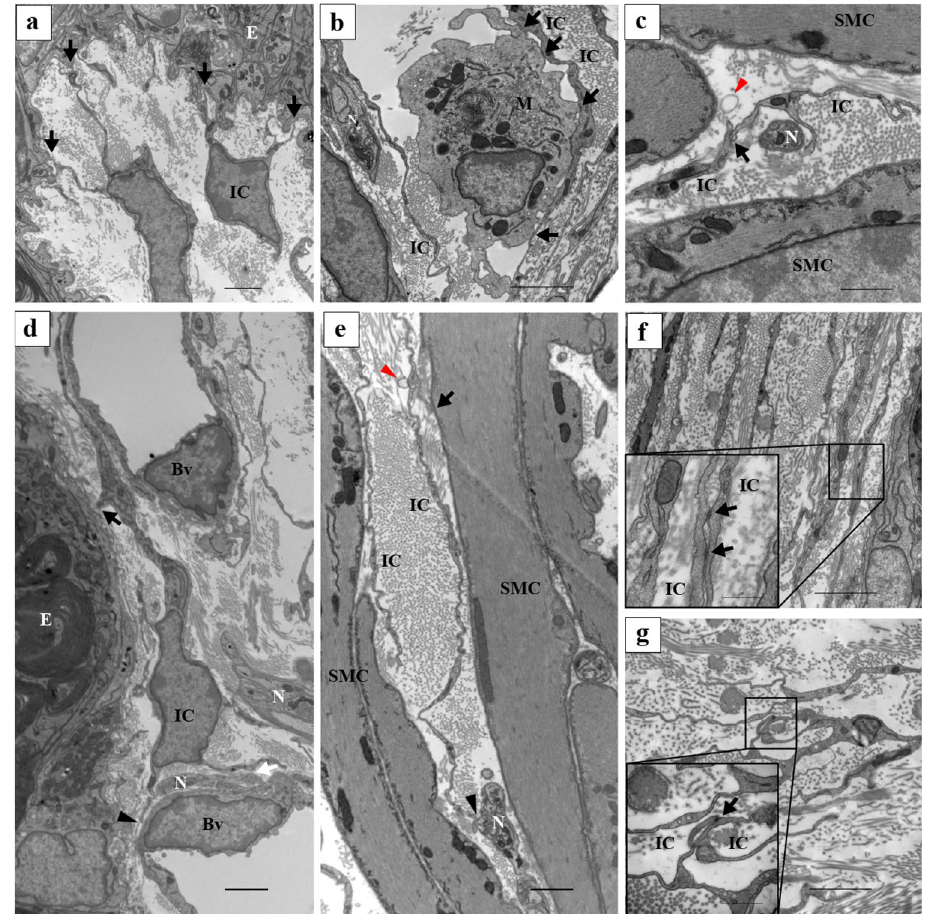
Figure 7. ( a ) The cell processes of the ICs were in close proximity to the epithelium (black arrows). ( b ) A cell process of the IC was close proximity to a macrophage (black arrows). A cell process of the IC wraps nerves and the close proximity to the cell process of the other IC (black arrows). ( c ) Exosome-like structure nearby cell process of the IC (red arrowhead). ( d ) The IC in the lamina propria were close proximity to surrounding tissues. The IC in the lamina propria was in close proximity to the epithelial cell (black arrow), a vascular endothelial cell (black arrowhead) and a nerve (white arrow). ( e ) The IC in the smooth muscle layer was in close proximity to the surrounding tissues. The IC in the smooth muscle layer was in close proximity to a smooth muscle cell (black arrow) and a nerve (black arrowhead). Exosome-like structure near the cell processes of IC (red arrowhead). ( f , g ) TEM images of contact areas between ICs. Higher magnification of the solid black line square area (inset at the lower left corner of ( f , g )). Electron-dense lines exist in the contact area between ICs (black arrows). IC, interstitial cells; E, epithelium; N, nerves; Bv, blood vessels; M, macrophages. Scale bars: 2 μm ( a – g ); 500 µm (inset at the lower left corner of ( f , g